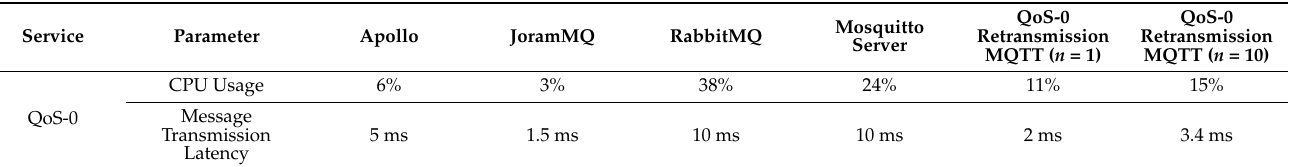
Table 1. Comparison of the improved MQTT protocol with Benchmark MQTT, JoramMQ [16], Apollo servers [16], and RabbitMQ